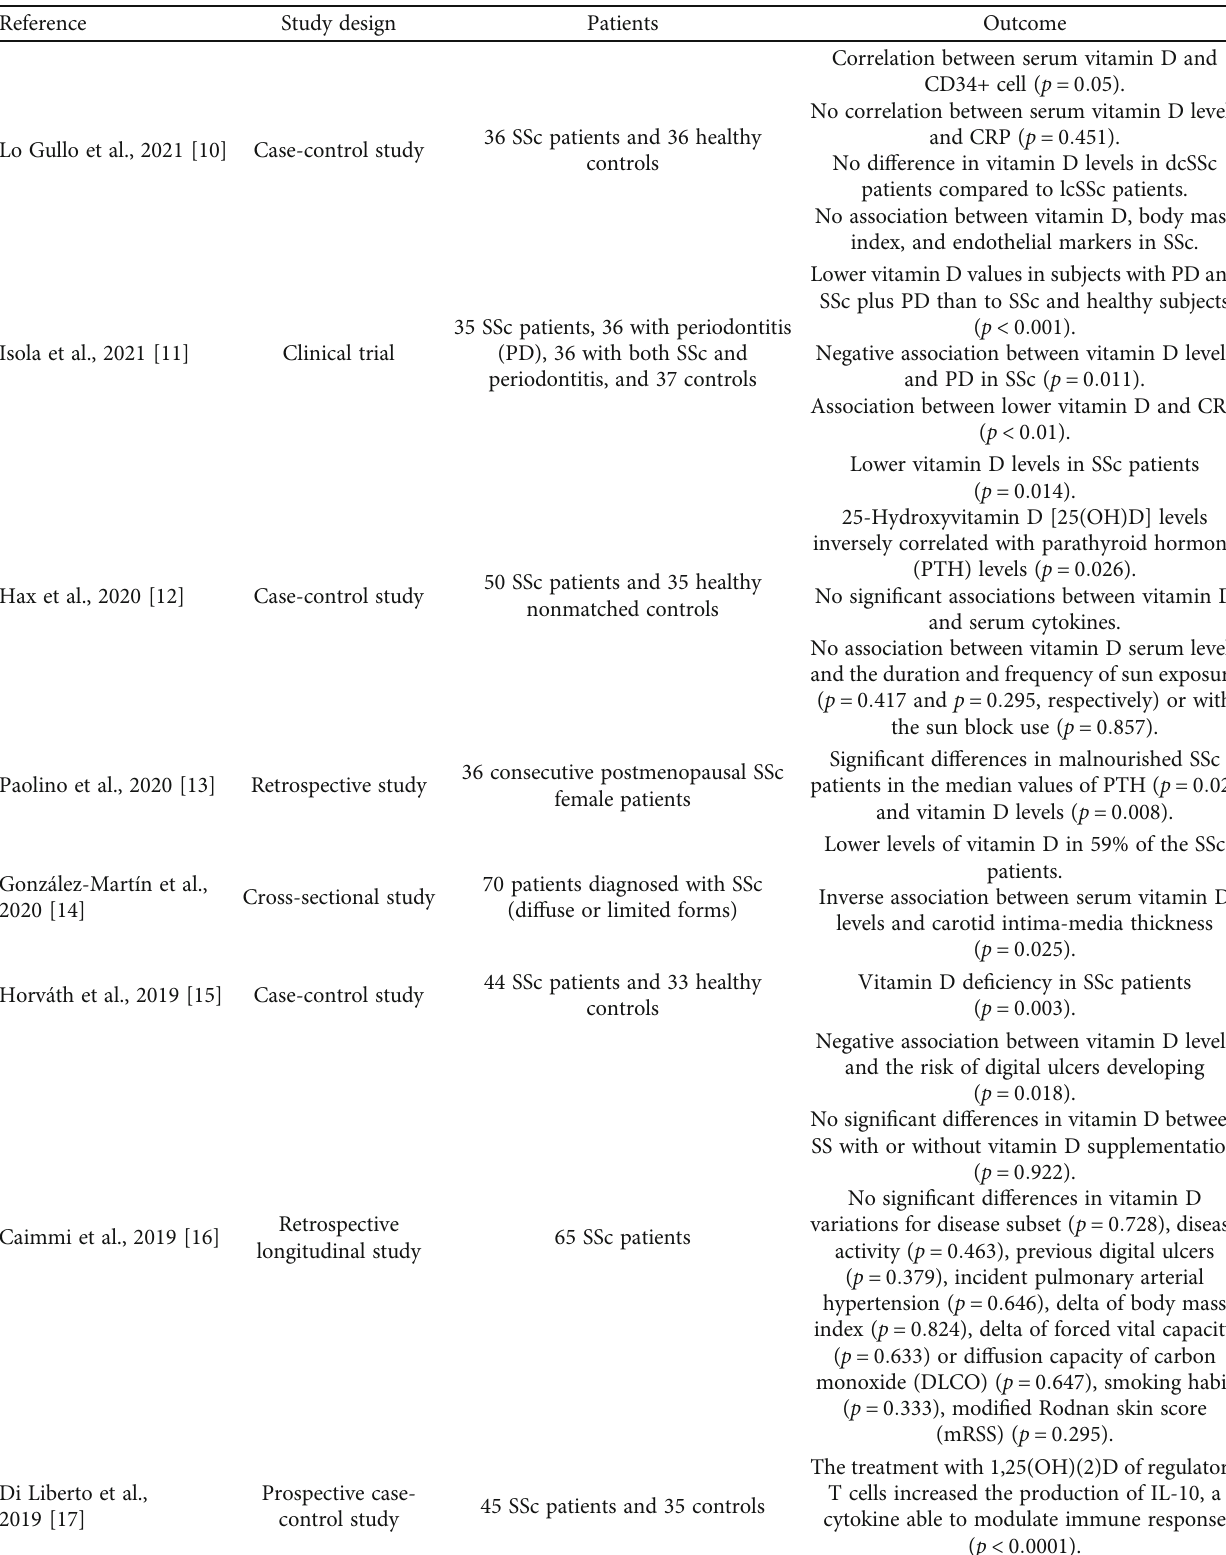
Table 1: Characteristics of selected studies on serum vitamin D in systemic